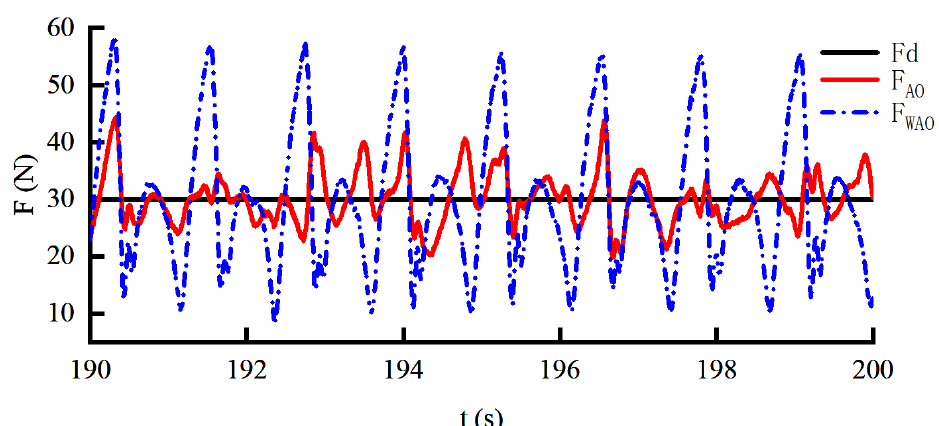
Figure 15. The constant force response curve under the HEIF-AO in the outer loop and the DOB in the inner loop.